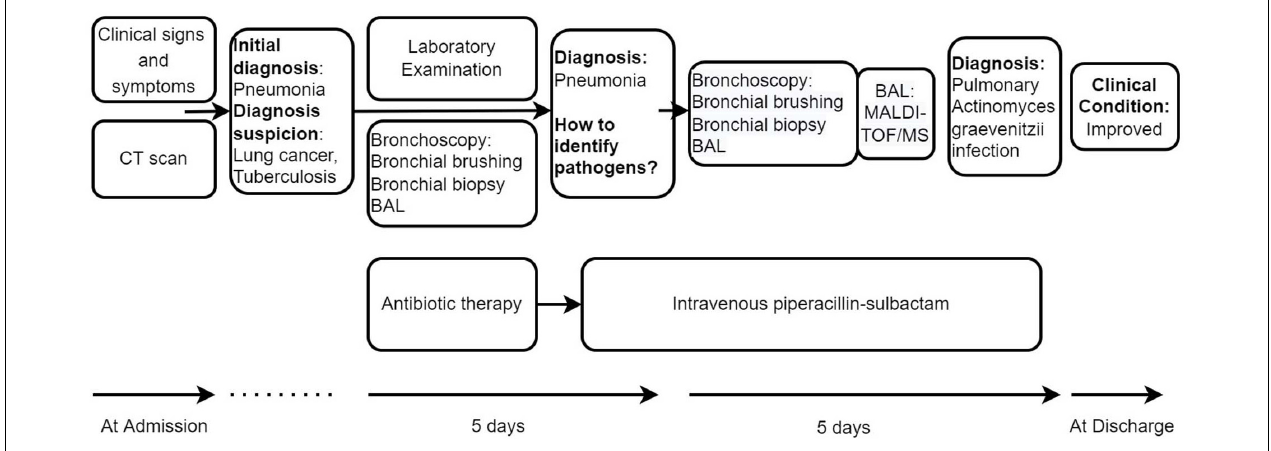
FIGURE 5 | Timeline with the most relevant data of the clinical